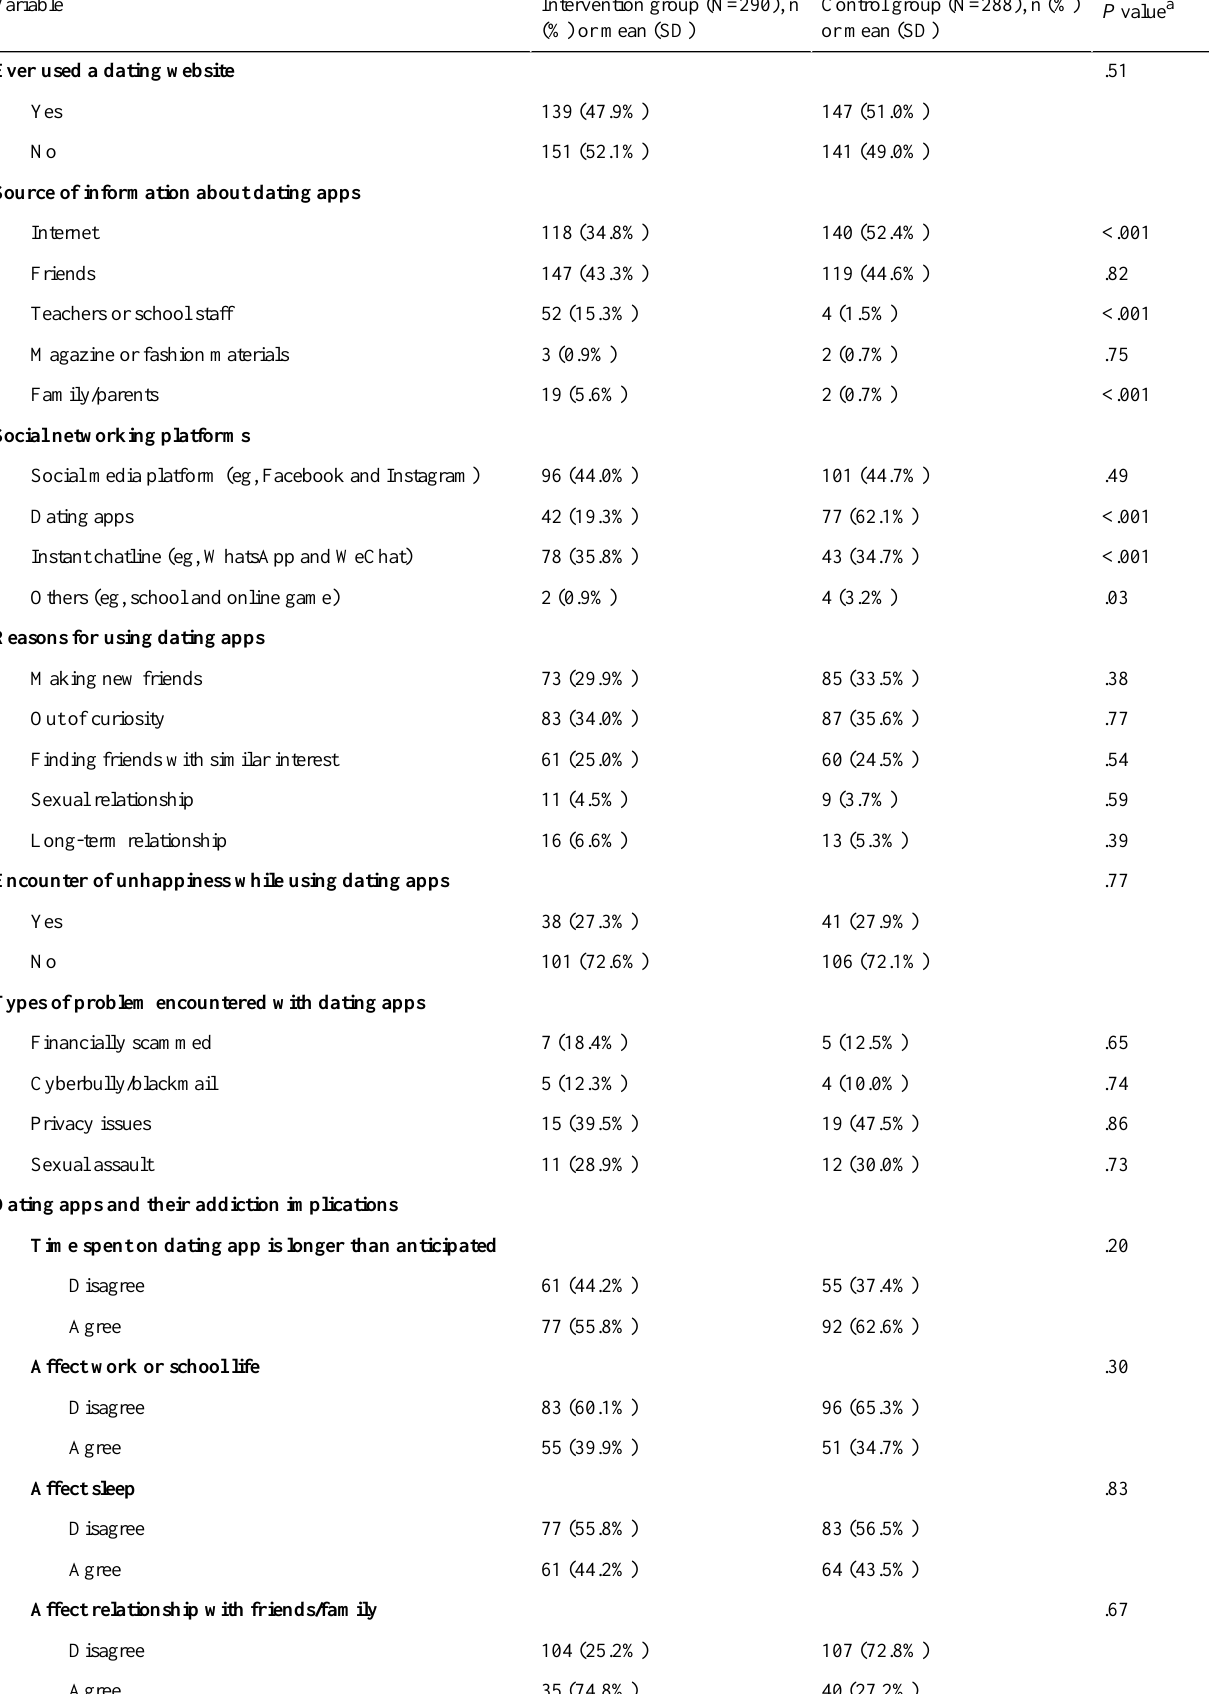
Table 2. Characteristics of the responses from participants about their dating app